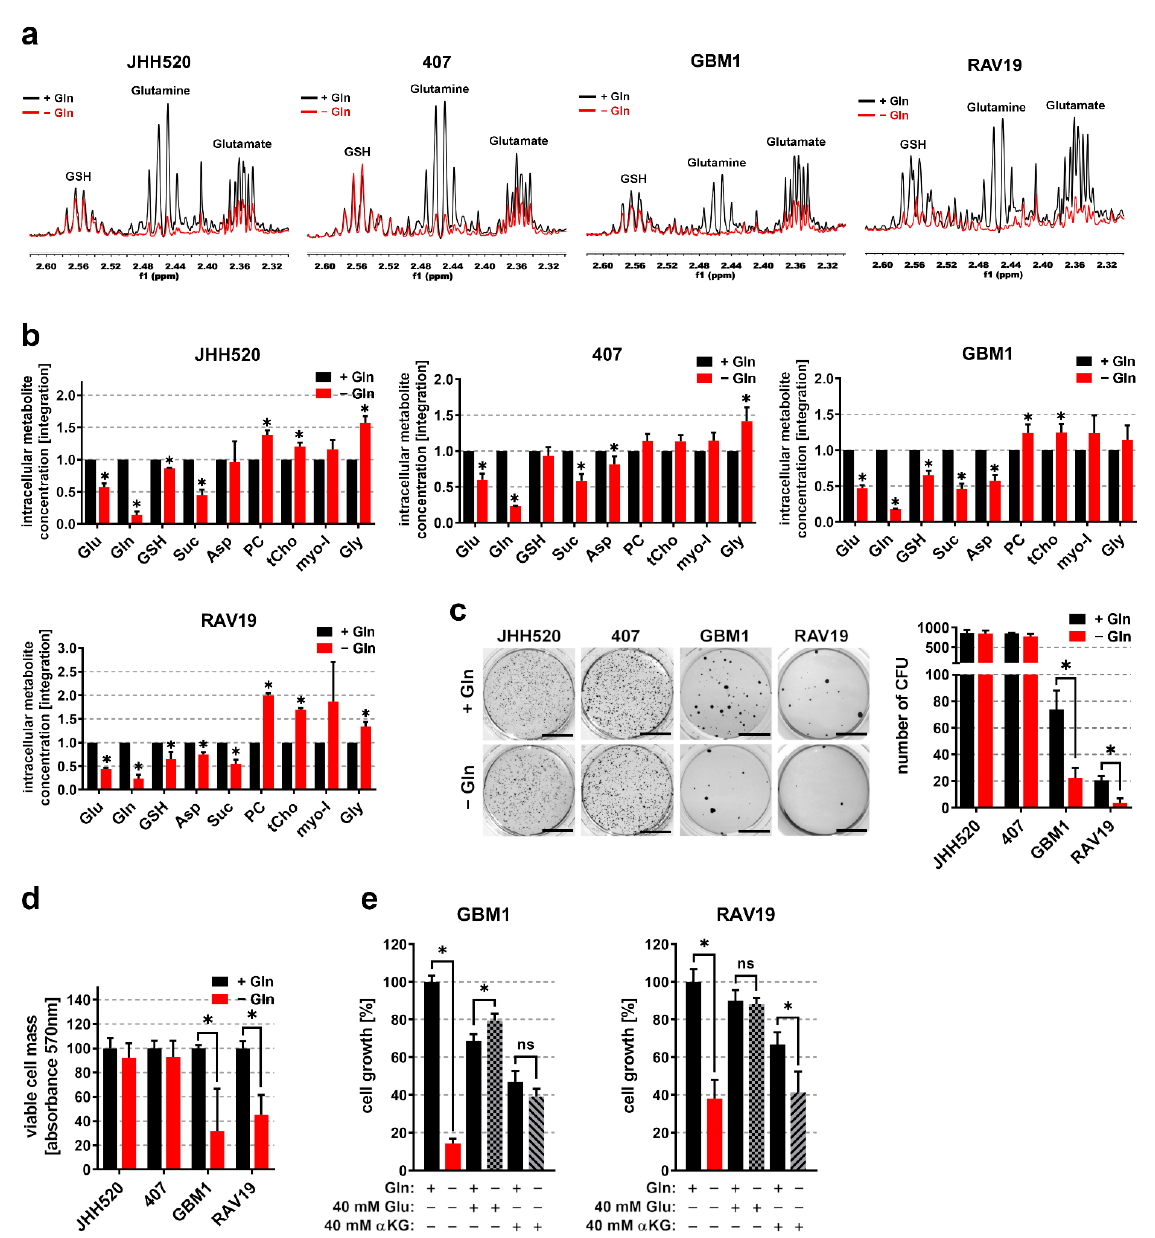
Figure 2. Starvation for L-glutamine targets barely clonogenic GSCs with low Gln/Glu ratios. Expanded regions from 1 H- NMR spectra showing GSH, Gln, and Glu multiplets ( a ) and relative metabolite concentrations ( b ) from metabolic extracts of GSC neurospheres cultured in the presence (black) or absence (red) of L-Gln ( n = 3). Gln starvation significantly reduced the in vitro clonogenicity ( c ) and cell growth ( d ) of GSCs with low Gln/Glu ratios (GBM1 and RAV19) ( n = 3). For in vitro clonogenicity experiments, representative pictures of NBT-stained colonies and quantifications of three soft agar colony formation assays are shown. Scale bar equals 1 cm. ( e ) Cell growth of sensitive GBM1 and RAV19 cells starved for 4 days for L-Gln in the presence of either 4 mM Glu, 4 mM αKG, or medium only ( n ≥ 3). For all assays, the data are presented as mean ± SD. Significance was calculated with Student’s t -test, * p < 0.05. Abbreviations: αKG, alpha-ketoglutarate; Asp, aspartate; CFU, colony-forming units; Gln, glutamine; Glu, glutamate; Gly, glycine; GSH, glutathione; myo-I, myo-inositol; n.s. not significant; PC, phosphocholine; ppm, parts per million; Suc, succinate; tCho, total choline.